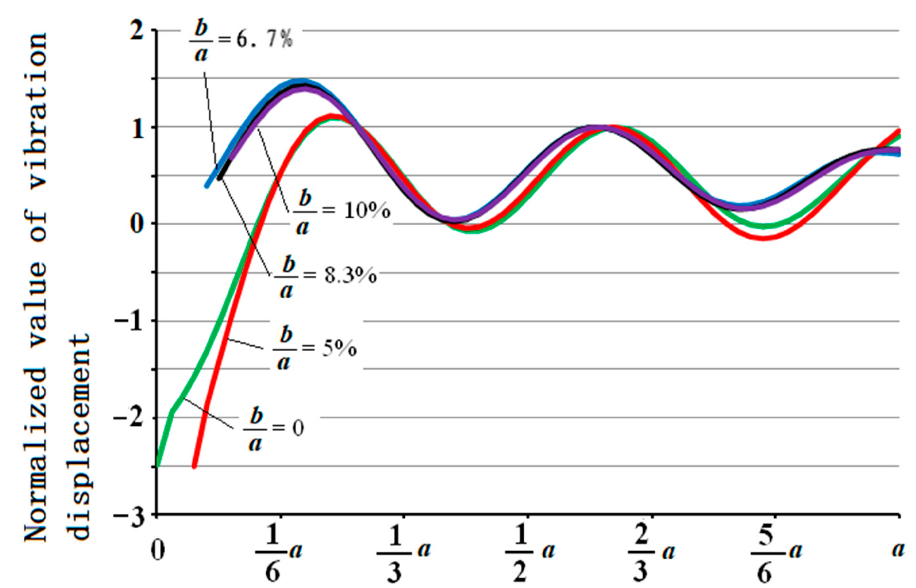
Figure 7. Normal vibration displacement curve with different b / a .